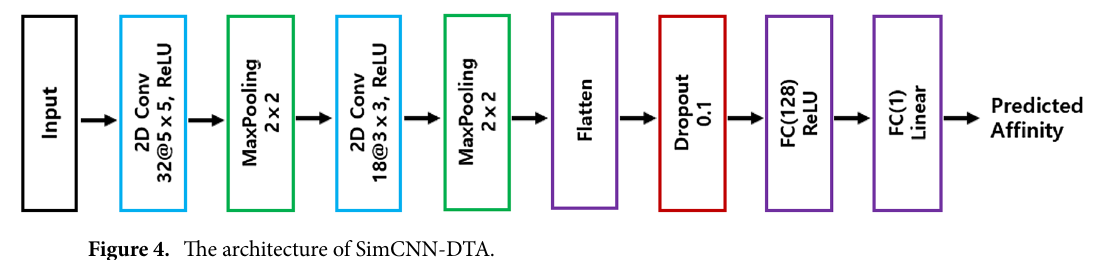
Figure 4. The architecture of